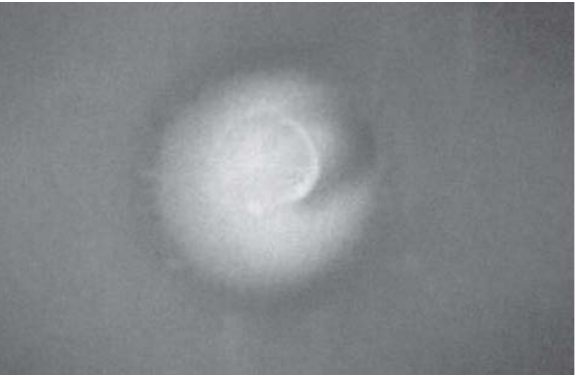
FIGURE 2- Mild genotoxicity of chlorhexidine gel containing zinc oxide against strain PQ35 in the SOS chromotest